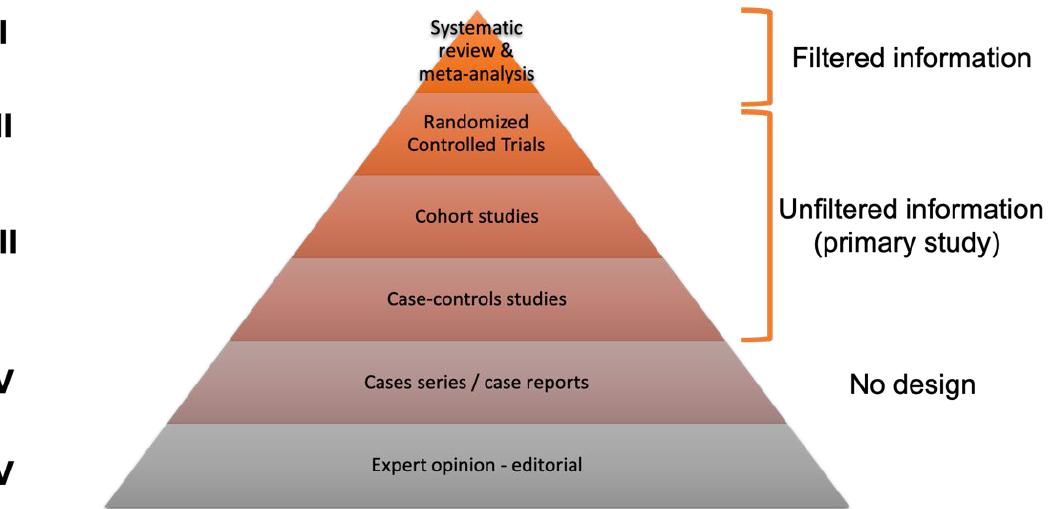
Figure 2. Study design and levels of evidence [16]. This pyramid could be more detailed, but the general idea is to differentiate the four kinds of studies: The meta-analysis of published studies is at the top (e.g., systematic review and meta-analysis), as level I evidence. Then the experimental studies— fully controlled (RCT) and pseudo-RCT (level II) quasi-experimental designs (i.e., prospective studies). The observational large-scale studies (cohort studies and case–control studies (level III)) and the case reports or case series are at the base of the pyramid, with a low level of evidence (level IV). Finally, expert opinion, not based on any scientific data or evidence, represents the lowest level of evidence (level